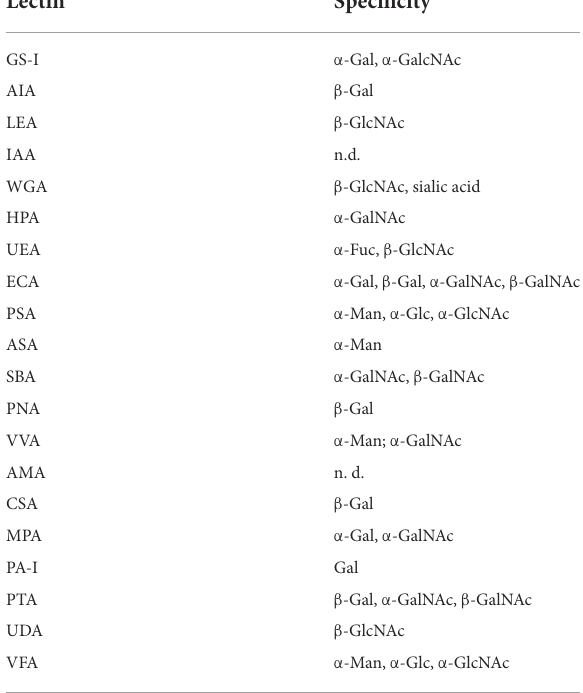
TABLE 2 Shortlist of lectins bound with a strong binding efficiency (see dark green shading in Figure 2). Lectin Specificity